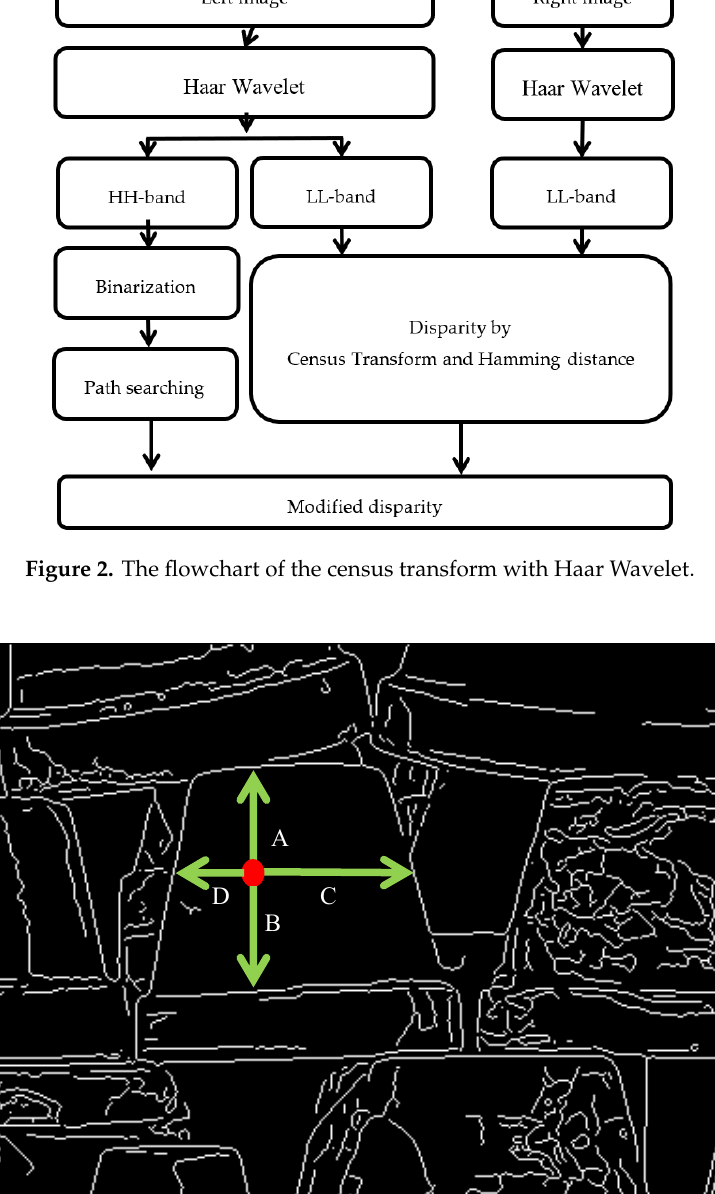
Figure 3. Example of the path searching of a (red) point.